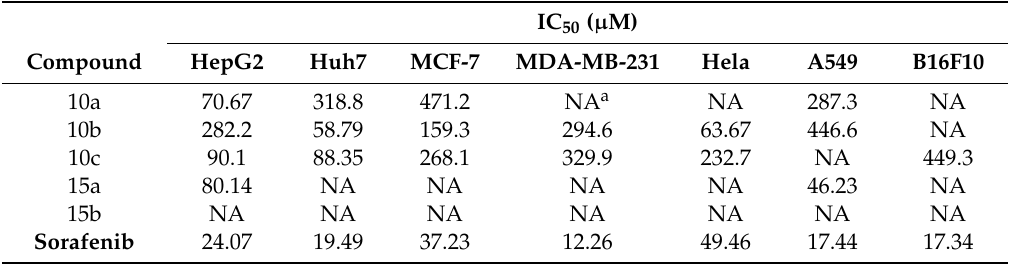
Table 1. Antiproliferation activities against seven cancer cell lines for 10a – c and 15a – b .